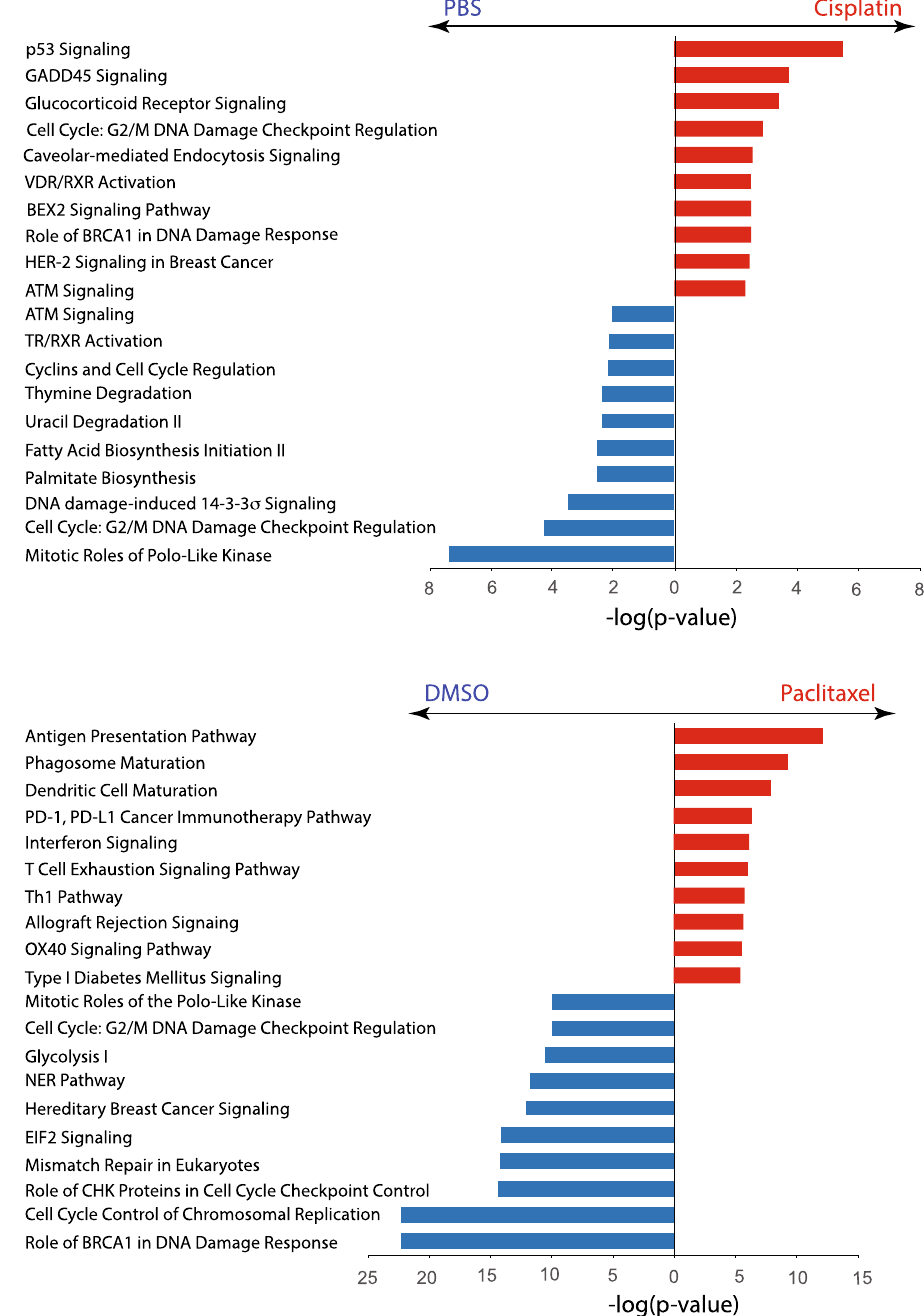
Figure 5. Canonical pathways affected by cisplatin or paclitaxel treatment. Top 10 differentially affected canonical pathways identified by Ingenuity pathway analysis are listed according to their p-value (-log). Red bars represent pathways enriched in chemotherapy-treated PDO, blue bars represent pathways enriched in vehicle- treated